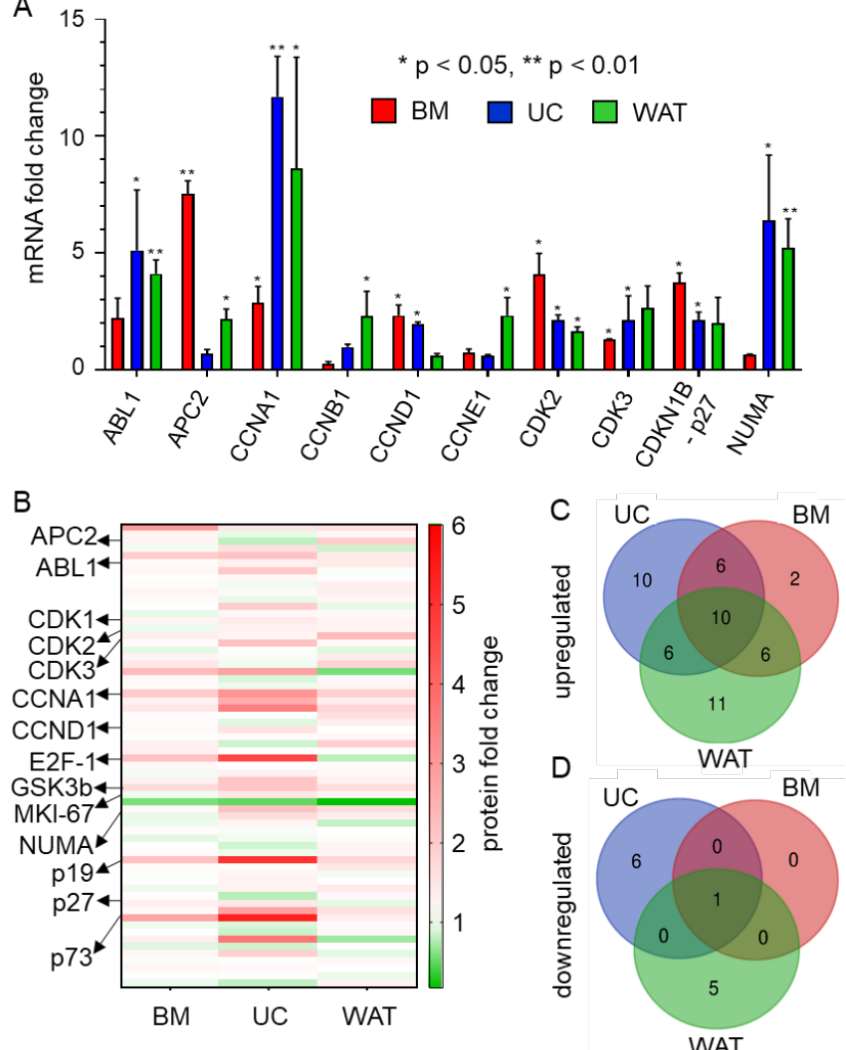
Figure 1. HPL-based culture conditions induce the expression of cell cycle-specific target genes. ( A ) RT-qPCR reveals that mRNA expression is significantly upregulated when BM- (red), UC- (blue) and WAT-derived stromal cells (green) are cultured in HPL. Data are shown as mean fold change values ± SD of biological triplicates measured in technical duplicates. ABL proto-oncogene 1 (ABL1), adenomatous polyposis coli protein 2 (APC2), cyclin A1 (CCNA1), cyclin B1 (CCNB1), cyclin D1 (CCND1), cyclin E1 (CCNE1), cyclin-dependent kinase 2 and 3 (CDK2, 3), cyclin-dependent kinase inhibitor 1B (CDKN1B, p27) and nuclear mitotic apparatus protein 1 (NUMA) . ( B ) Heat map of cell cycle-specific antibody array depicting the up- (shown in red) and downregulated (shown in green) protein expression levels of 64 different specific cell cycle targets of stromal cells cultured in HPL compared to FBS. Data depicted are mean fold change values (HPL versus FBS) of biological triplicates measured in quadruplicates. ( C , D ) Venn diagrams of significantly up- and downregulated cell cycle-associated proteins show distinct source dependence, but also common protein expression patterns for BM-, UC- and WAT-derived stromal cells cultured in HPL.